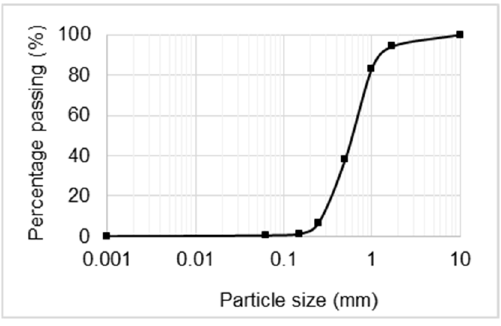
Figure 1. Size distribution of the sand used.